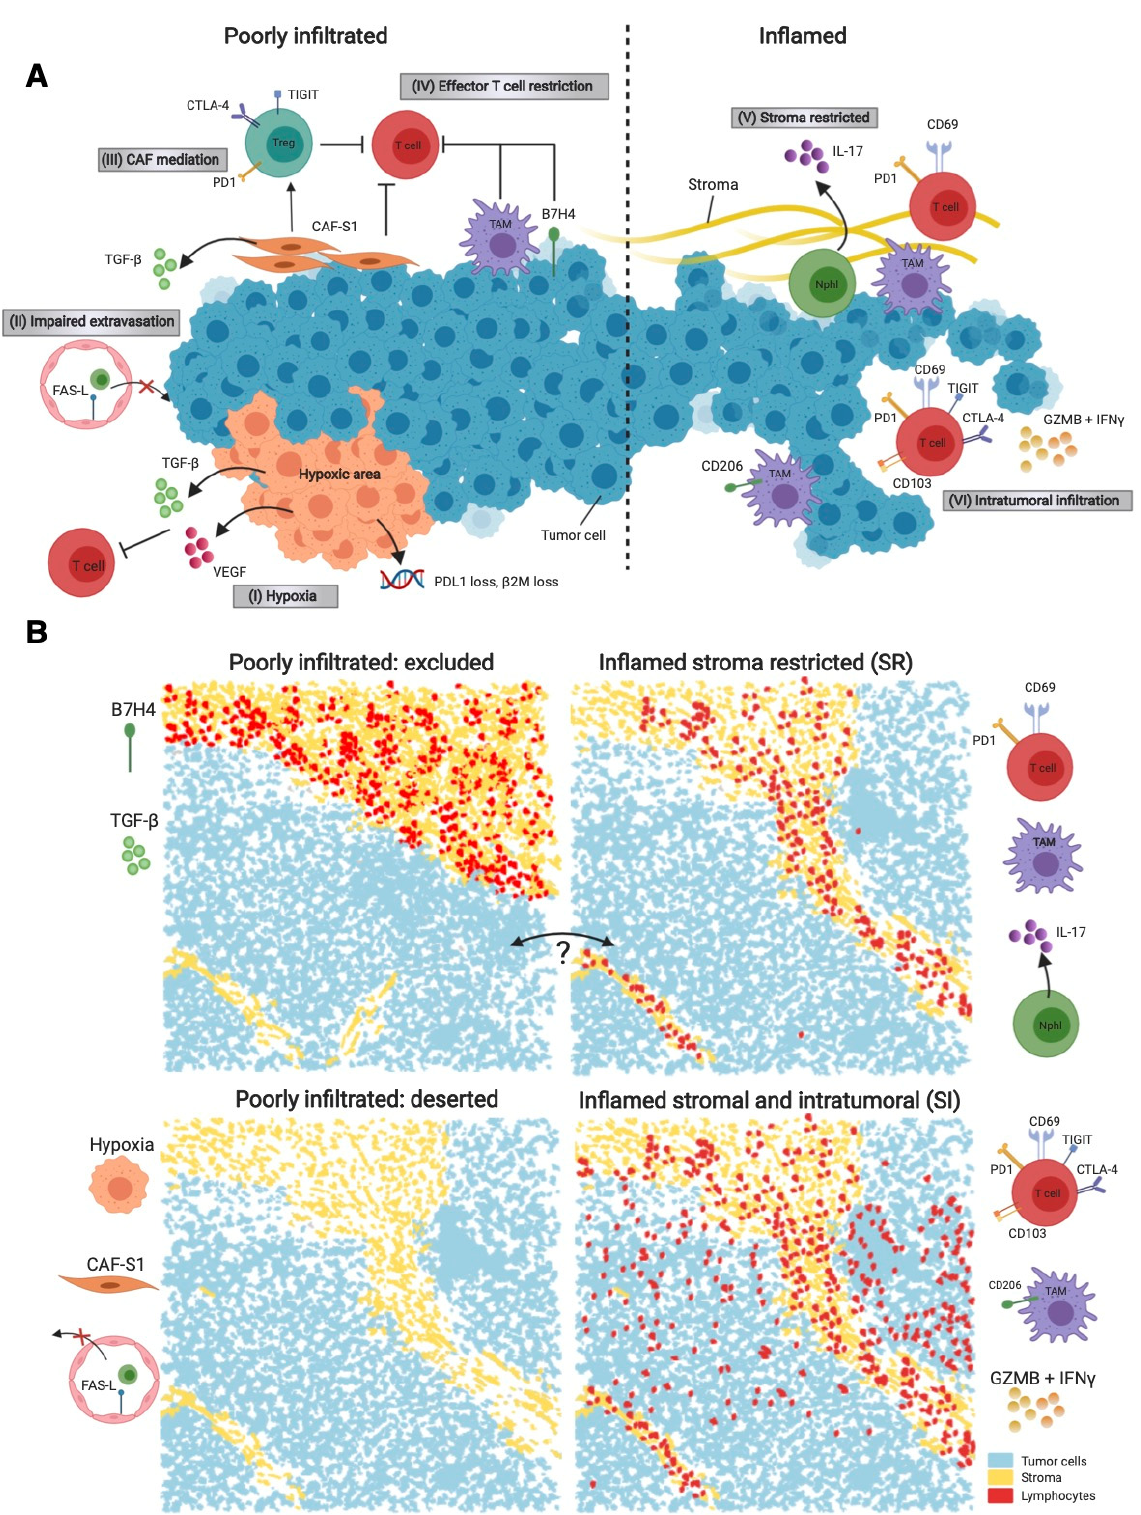
Figure 1. The spatial lymphocytic phenotypes of immune infiltration in triple negative breast cancer (TNBC). ( A ) A schematic illustration of a poorly-infiltrated (left-side) and inflamed (right-side) tumor with key markers and processes. (I) Hypoxia in the tumor promotes the production of pro-angiogenic factors, including TGF- β and vascular endothelial growth factor (VEGF), which can both modulate and inhibit effector T cells; (II) Low infiltration of lymphocytes occurs due to their impaired extravasation, e.g., through endothelial expression of FAS-ligand (FAS-L); (III) CAF mediation, e.g., via CAF-S1 fibroblasts, inhibit T cells directly and via the modulation of regulatory T cells; (IV) Effector T cell restriction through tumor associated macrophages (TAMs) and immuno-inhibitory molecules, such B7H4. B7H4 can be expressed